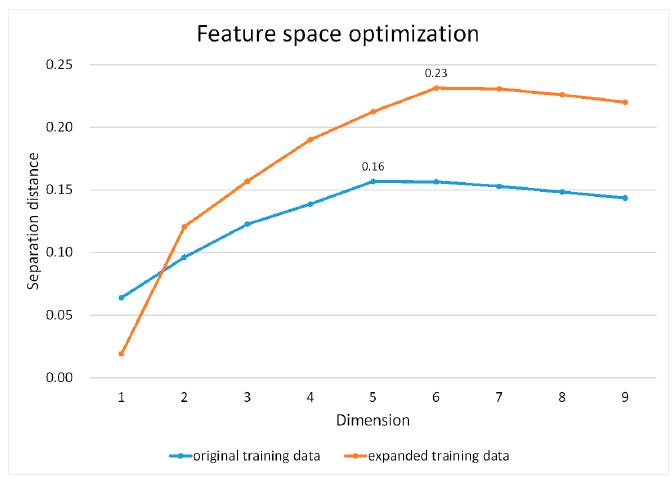
Figure 6. Feature space optimization using nine features based on two sets of training data.